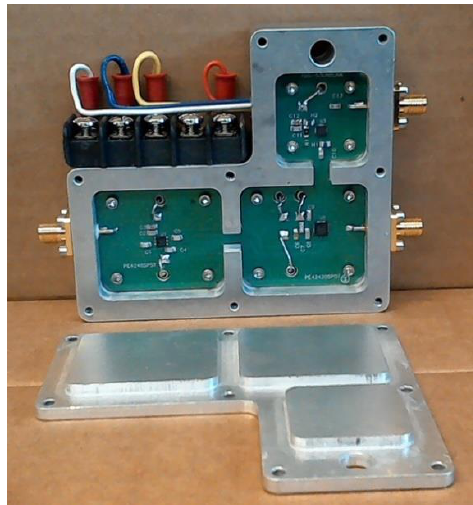
Figure 4. Photograph of the switch/amplifier module illustrating compartmentalization of the single-pole/single-throw (SPST; left), single-pole/double-throw (SPDT; lower right), and low noise amplifier (LNA; upper right), and associated cover with raised surfaces.